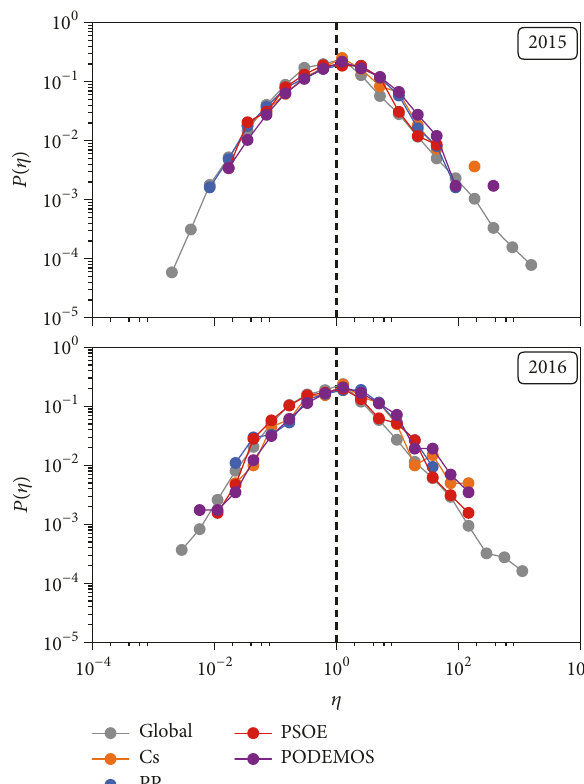
Figure 8: Probability distributions of efficiencyfor Twitter accounts associated with each party and for the whole set of users. Top: 2015 electoral campaign. Bottom: 2016 electoral campaign. The value 𝜂 = 1 is marked with a dashed line.